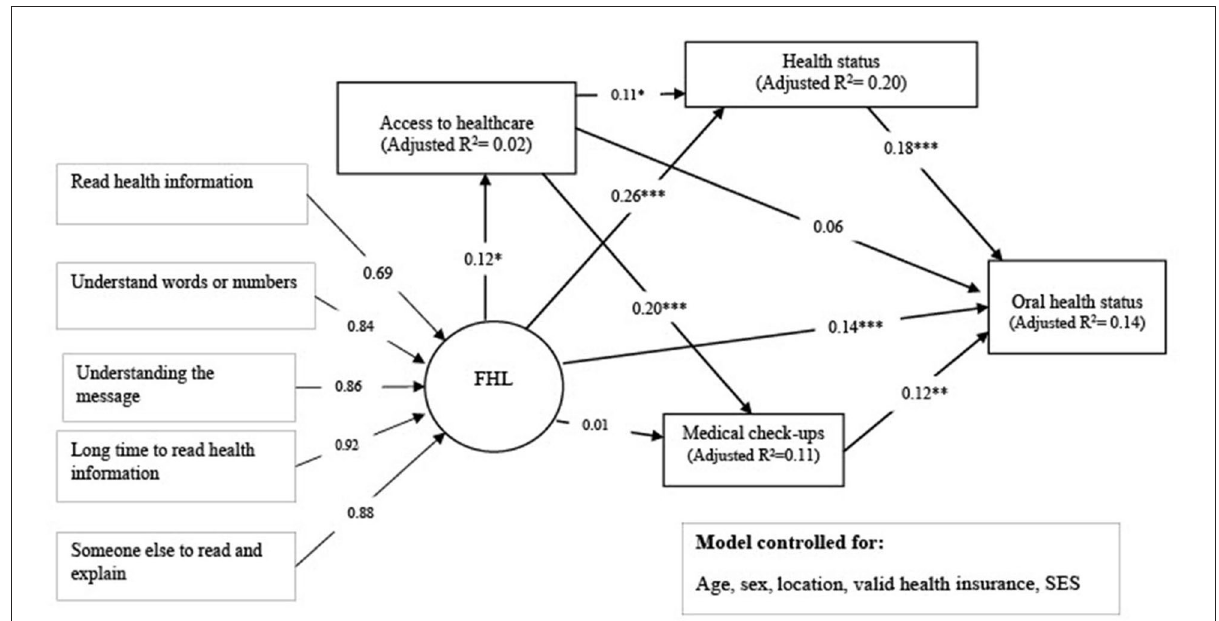
FIGURE2 The association of health literacy, general health status, access to healthcare, and medical check-ups with oral health literacy by SEM. Coefficients are based on standardized estimates. *** p < 0.001; ** p < 0.01; * p < 0.05. Model fit indices: CMIN/df = 1.920 ( p -value = 0.000), GFI = 0.976, AGFI = 0.939, CFI = 0.982, IFI = 0.982, RMSEA = 0.045.